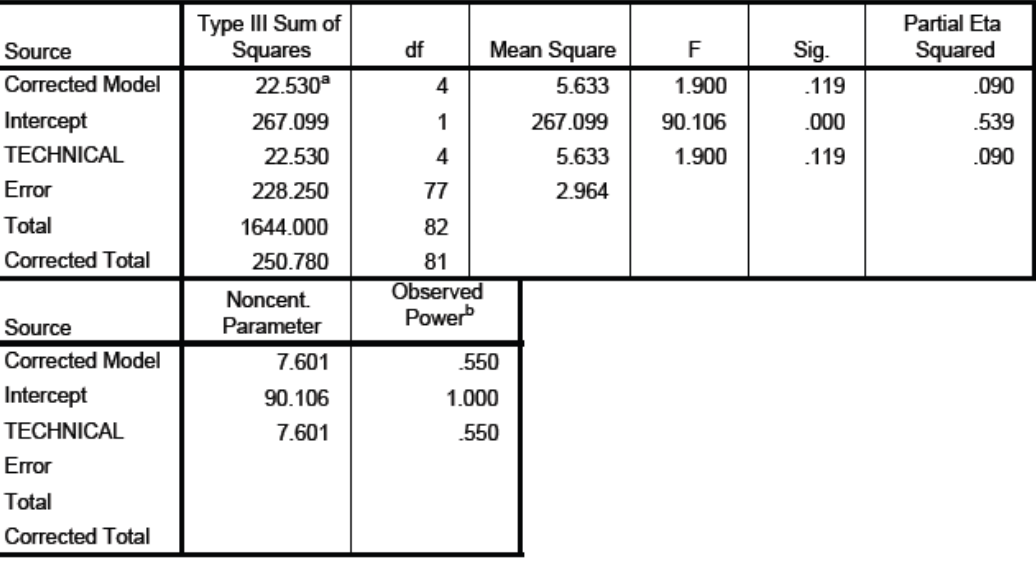
Figure B.12. ANOVA analysing enjoyment levels in regard to technical